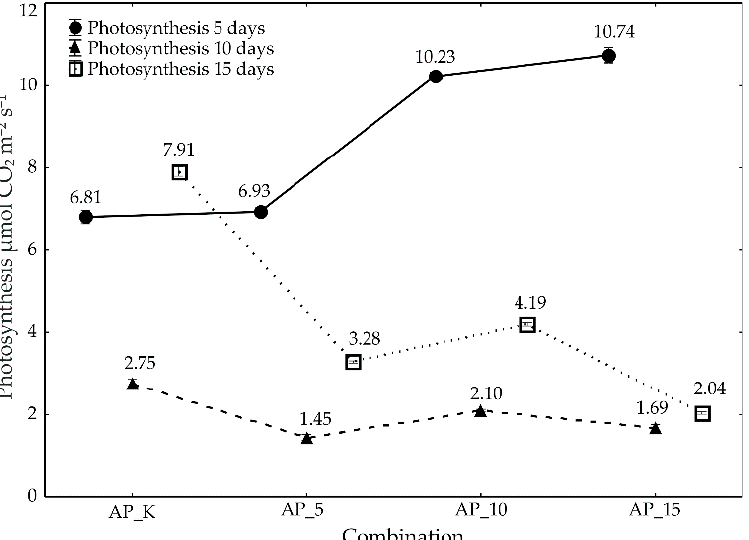
Figure 1. Intensity of the course of photosynthesis in the set time intervals in peas with different numbers of foraging aphids of A. pisum . Vertical lines at mean values indicate SE. Table 1. Values of the Pearson linear correlation coefficient r for the intensity of photosynthesis and transpiration and for the number of foraging aphids in the set time intervals (N =